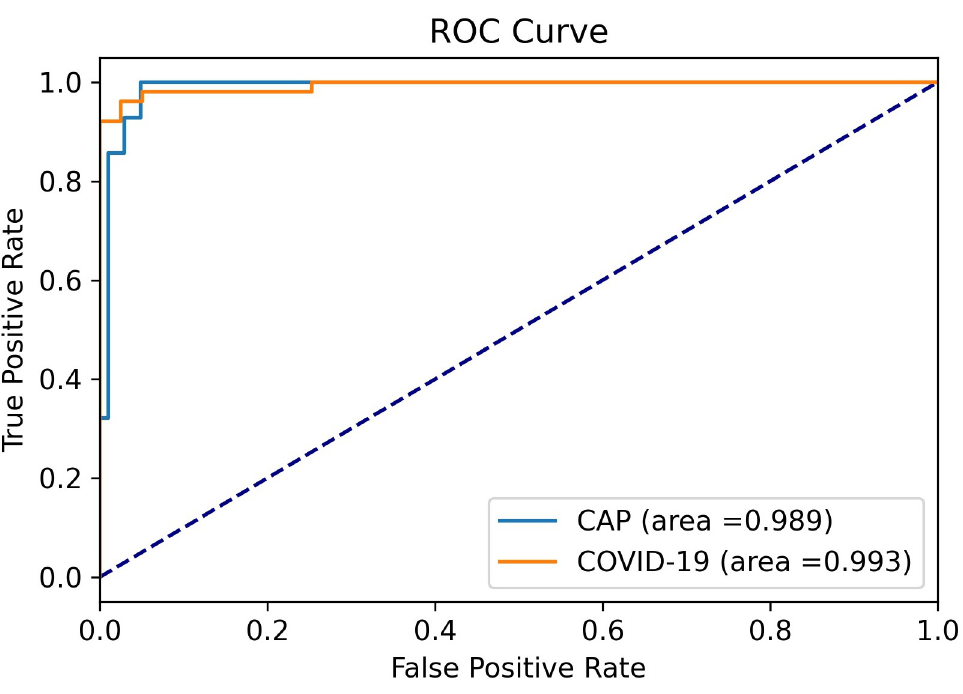
Fig 5. ROC curves for COVID-19 vs. others and CAP vs.